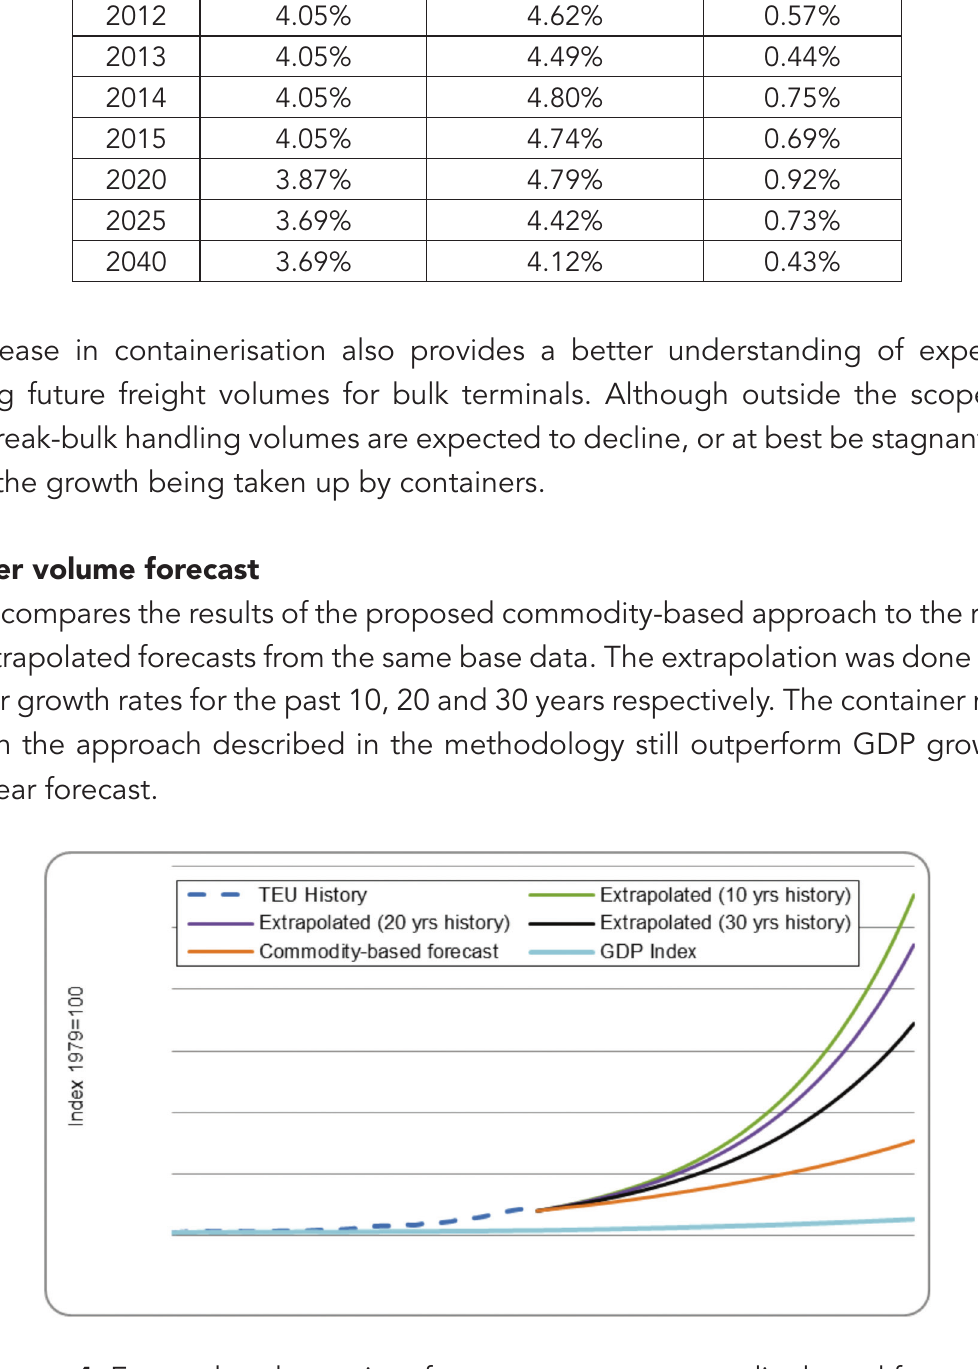
Figure 4: Extrapolated container forecasts versus commodity-based